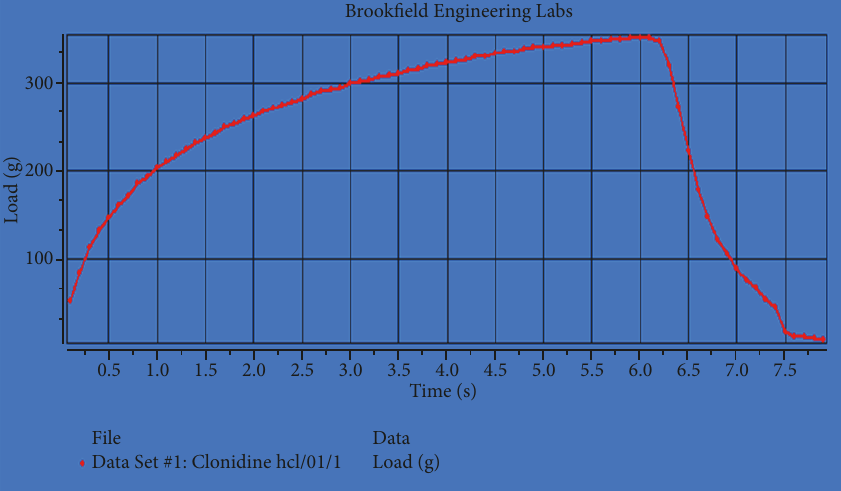
Figure 3: Tensile strength of optimized (F6) formulation.